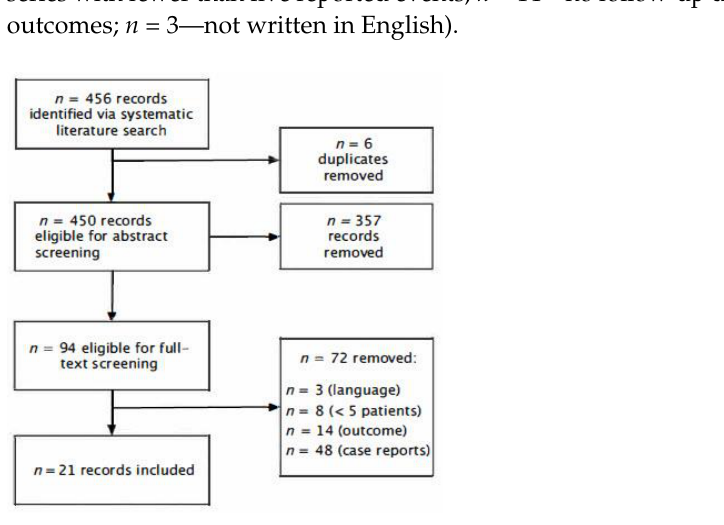
Figure 2. Flow diagram visualizing the selection process for the included publications.